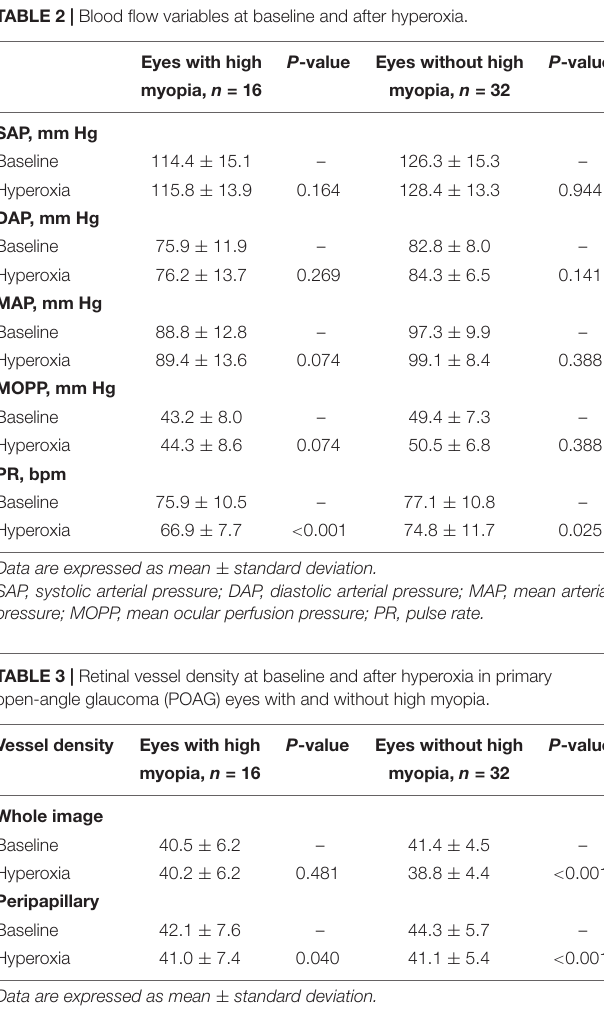
TABLE 2 | Blood flow variables at baseline and after hyperoxia.